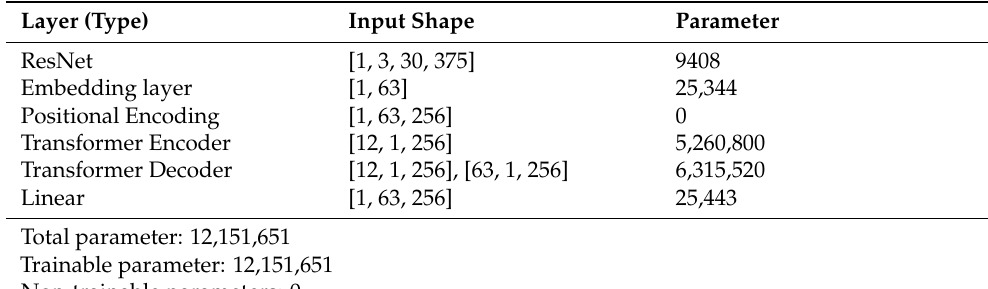
Table 2. Output shape and number of parameters of each layer in the proposed ResNet-101T model. Layer